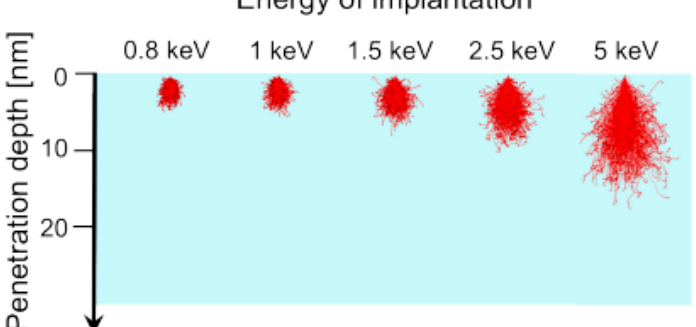
Figure 6. Results from SRIM software simulation showing the spatial distribution (penetration depth in nm) of the low-energy (5 keV or less) nitrogen ions in the diamond lattice as a function of the kinetic energy of the incident ions. Adapted from [23].